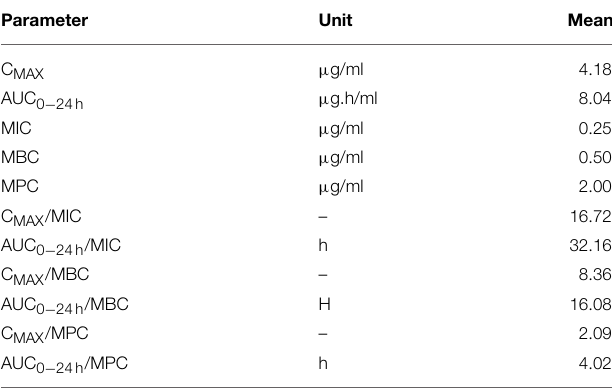
TABLE 5 | PK/PD Modeling of ex-vivo data after administration of Cefquinome in cattle ( n = 6 ).